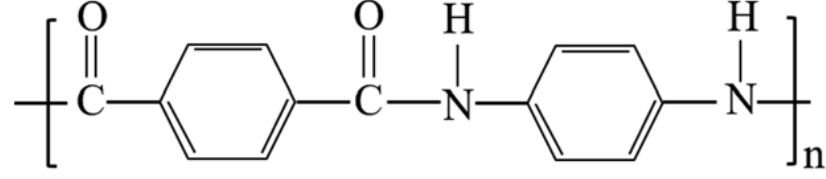
Figure 2. Molecular structure formula of Kevlar fiber.